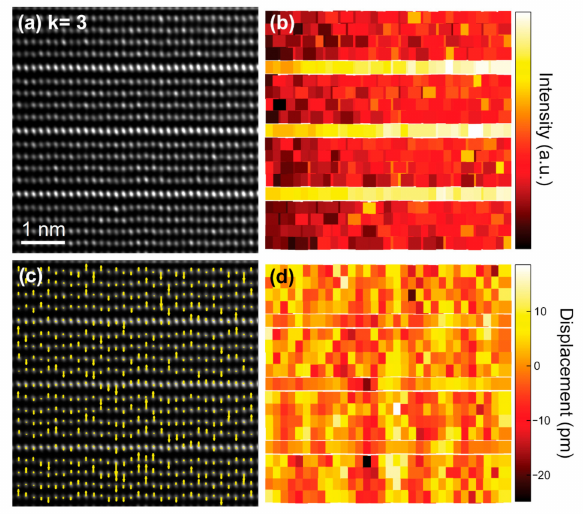
Figure 9. ( a ) Deconvoluted HAADF-STEM image of the k = 3 term revealing the undulation of the rows of Zn/In atomic columns. ( b ) Intensity map of the Zn/In atomic columns as obtained from the HAADF signal. ( c ) Atomic displacements along the (vertical) [001] direction of the Zn/In atomic columns measured relative to the center of each atomic row. The vectors in the arrow map are plotted along the displacement direction of the Zn/In cations, i.e., away from the oxygen columns. ( d ) Extracted fit of the atomic displacements for the Zn/In atomic columns plotted at their fitted